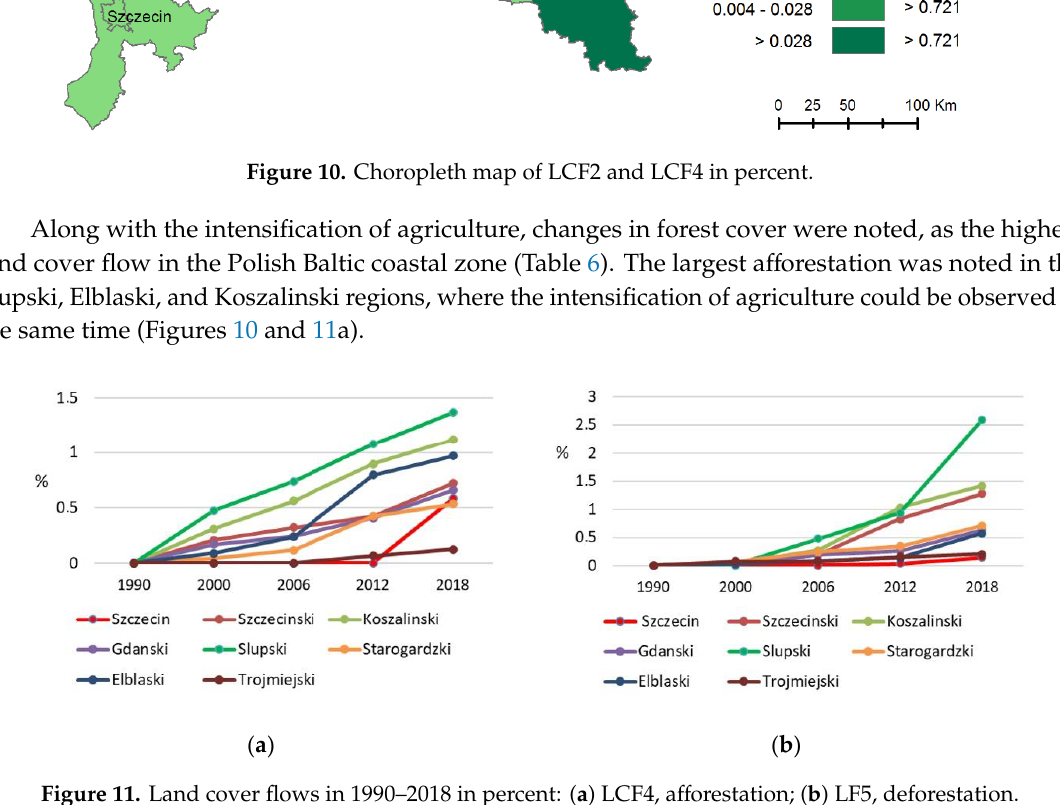
Figure 11. Land cover flows in 1990–2018 in percent: ( a ) LCF4, afforestation; ( b ) LF5, deforestation.